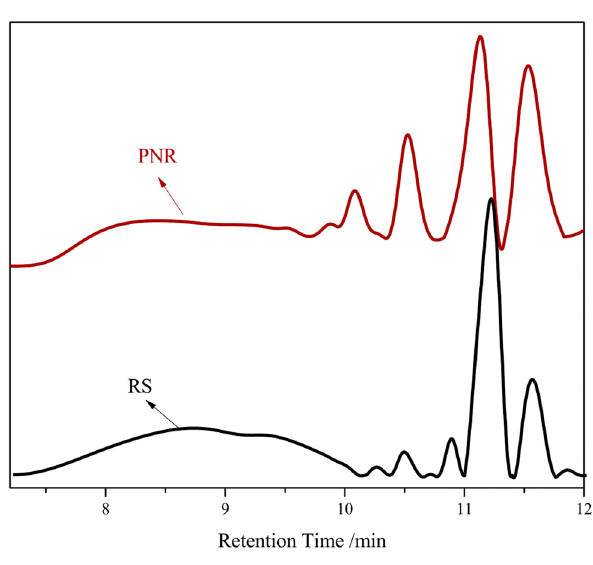
Figure 4: GPC results of PNR and